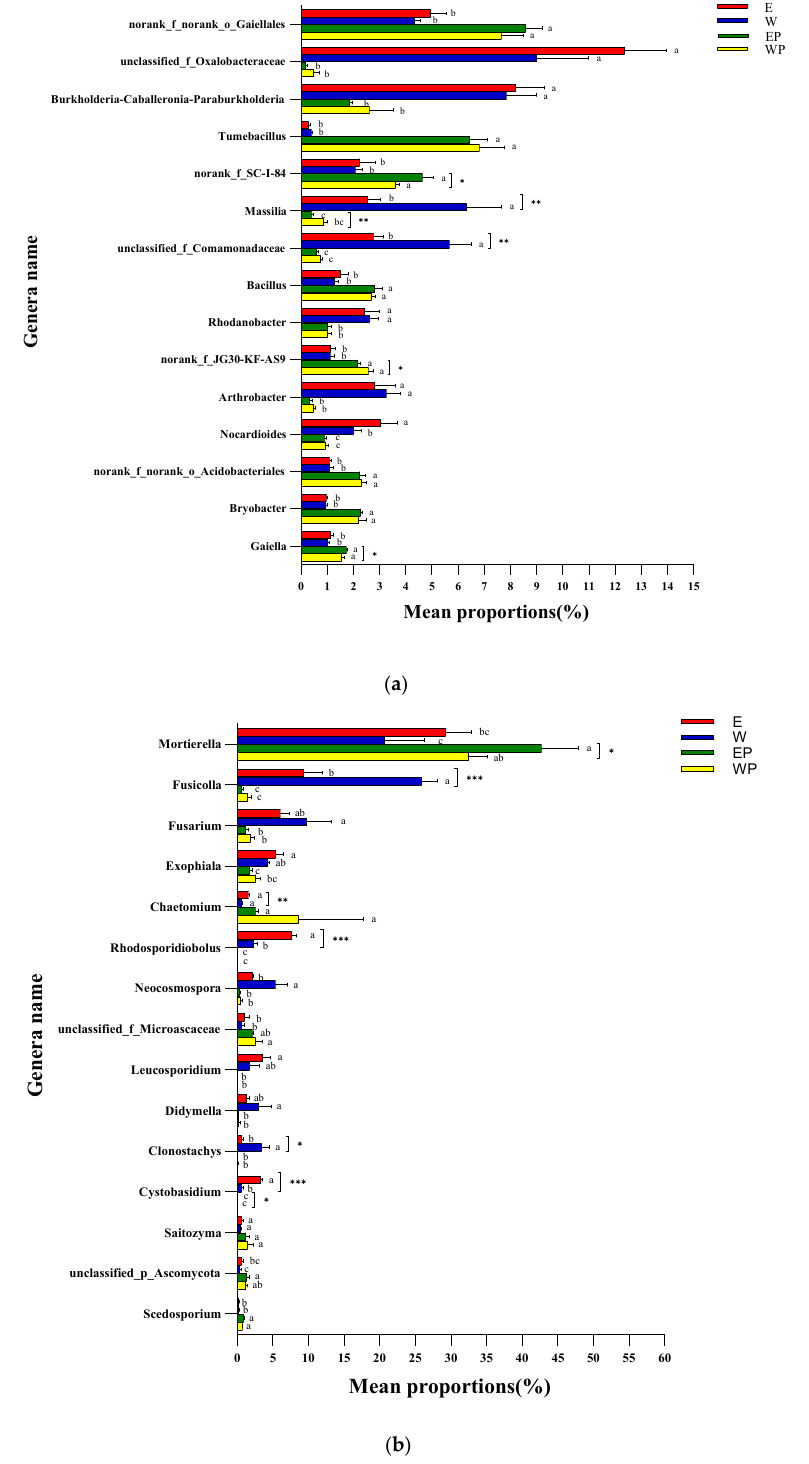
Figure 6. Genus-level relative abundance and major changes of the top 15 bacterial and fungal taxa in soil samples applied to peanut root exudates or distilled water. ( a ) Bacteria; ( b ) fungi. E: grapevine replanting soil irrigated with peanut root exudates, W: grapevine replanting soil irrigated with distilled water, EP: rhizosphere soil of grapevine seedling irrigated with peanut root exudates for 28d+24d, WP: rhizosphere soil of grapevine seedling irrigated with distilled water for 28d+24d. *, ** or *** indicated significant difference at p < 0.05, p < 0.01, or p < 0.001 between E and W or between EP and WP (Student’s t -test). The different letters represent significant differences at p < 0.05 (Tukey’s test). Figure 6b shows the relative abundance of the top 15 fungal taxa at the genus level.